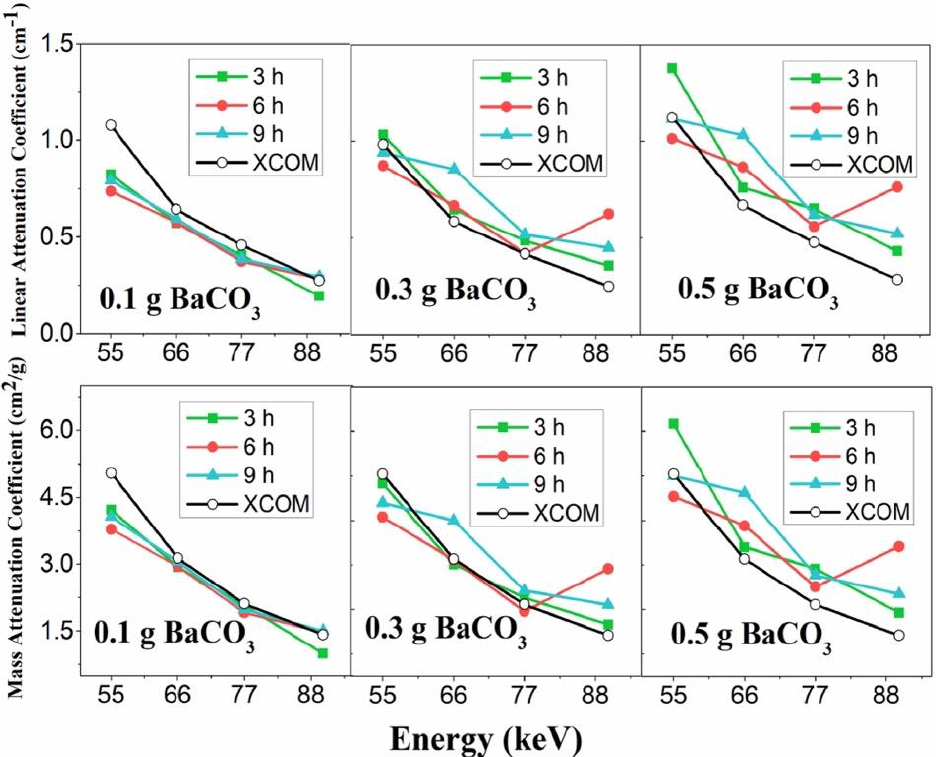
Figure 20. The experimental values of linear attenuation coefficient (µ) and mass attenuation coef- ficient (µ m ) for different delignification times and BaCO 3 content (filled symbol indicated by 3, 6, and 9 h). For comparison, the theoretical calculation (XCOM database) from the National Institute of Science and Technology (India) (open symbol) is included. Reprinted with permission from [40], copyright 2022, Elsevier.